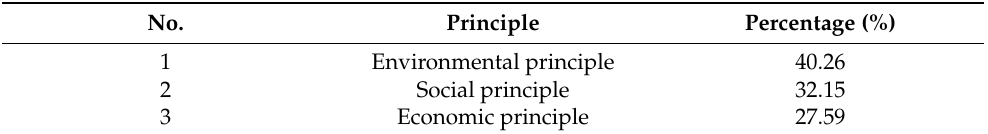
Table 2. Importance ranking in percentage of forest certification principles assessed by the Analytical Hierarchy Process in this study.